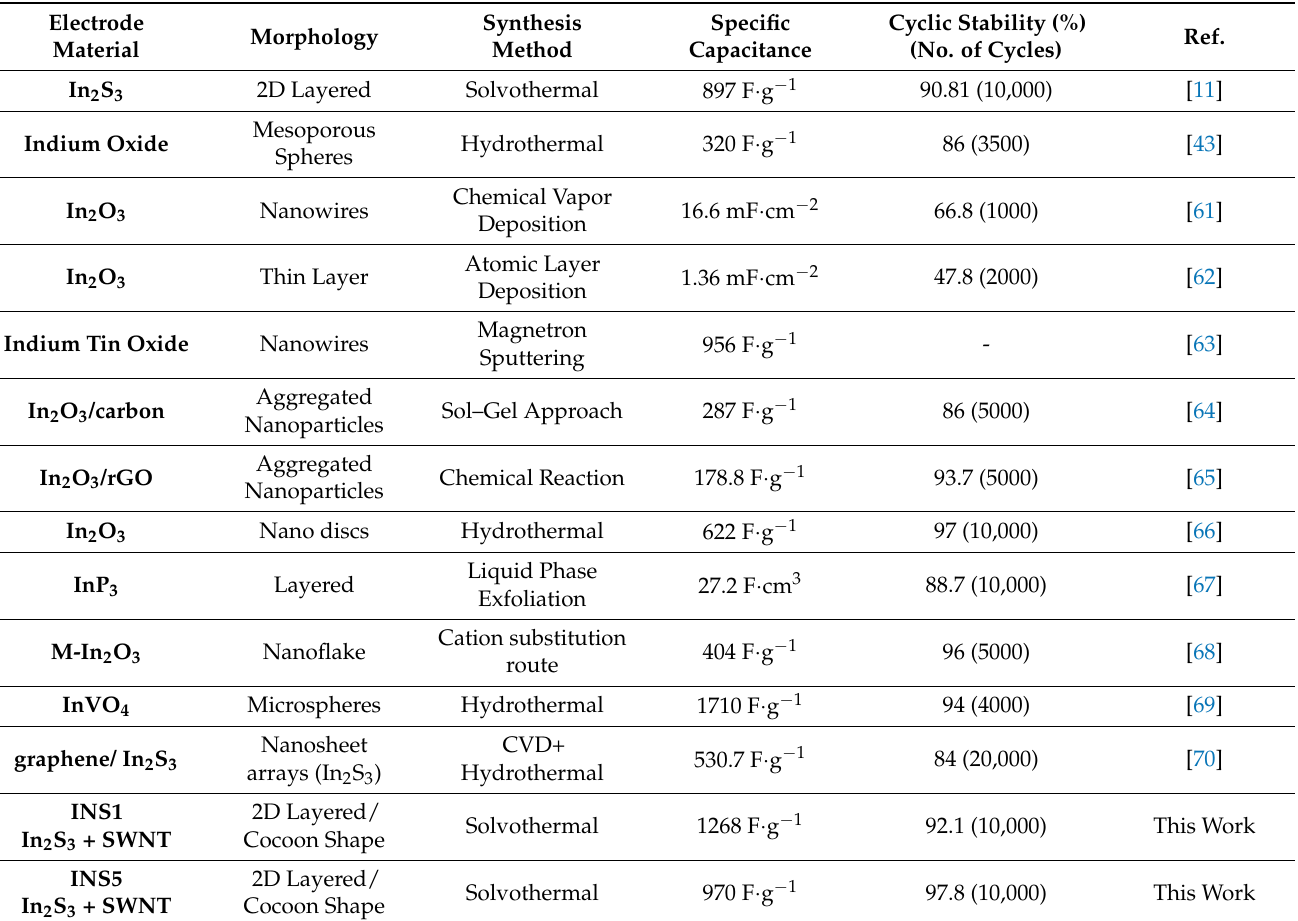
Table 3. Comparison of electrochemical characteristics of previously reported indium-based electrode materials and current